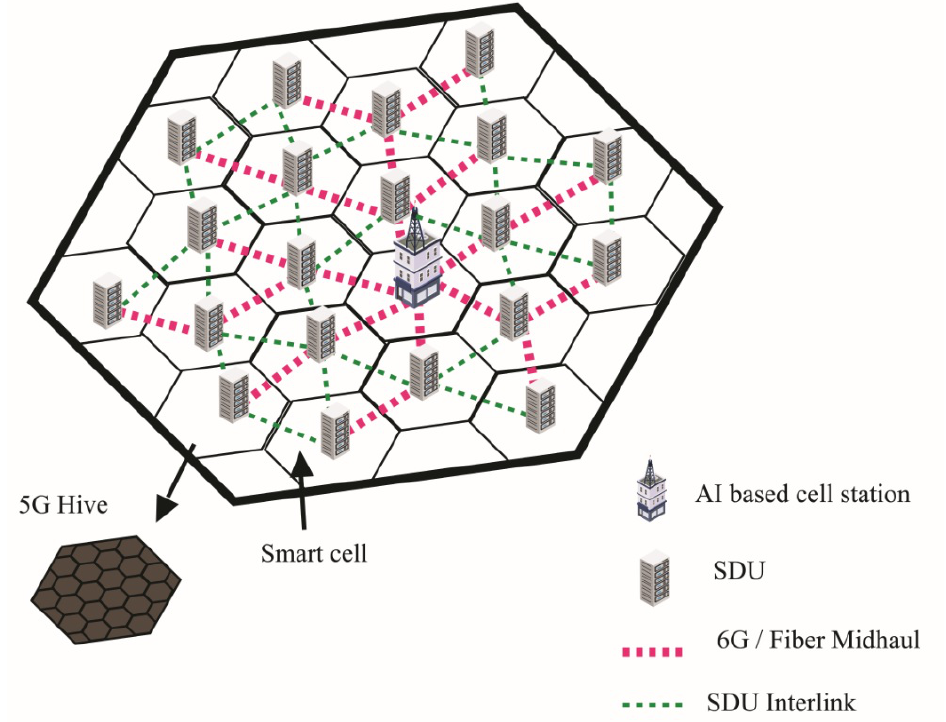
Figure 4. Hive of smart